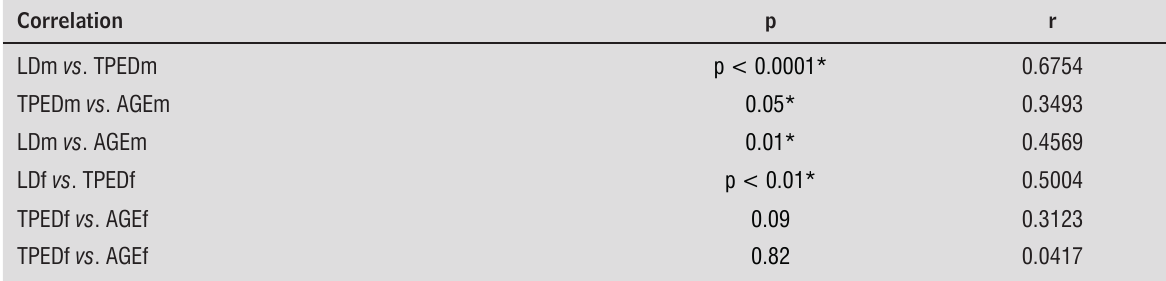
Table 4 - Correlations between characteristics referring to the gender of the